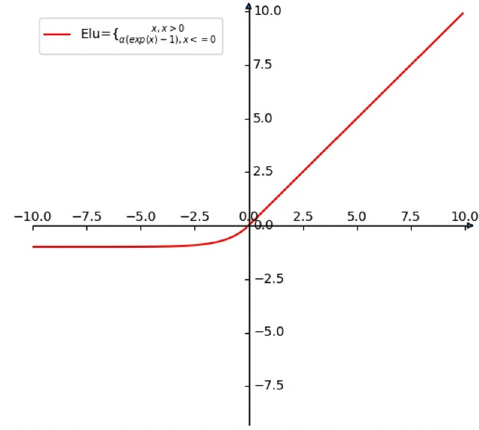
Figure 6. ELU function diagram.